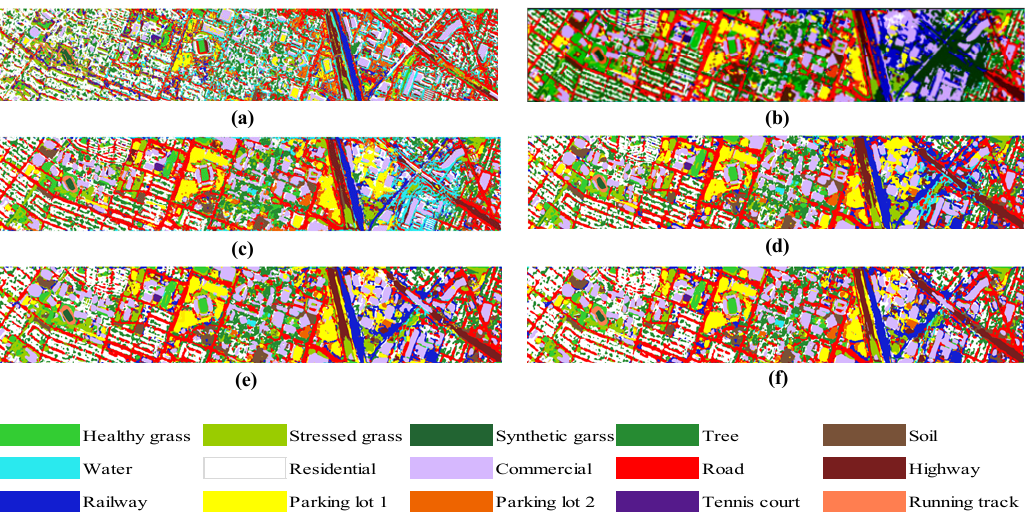
Figure 8. The Houston 2013 dataset: Classifications generated from different features and models.